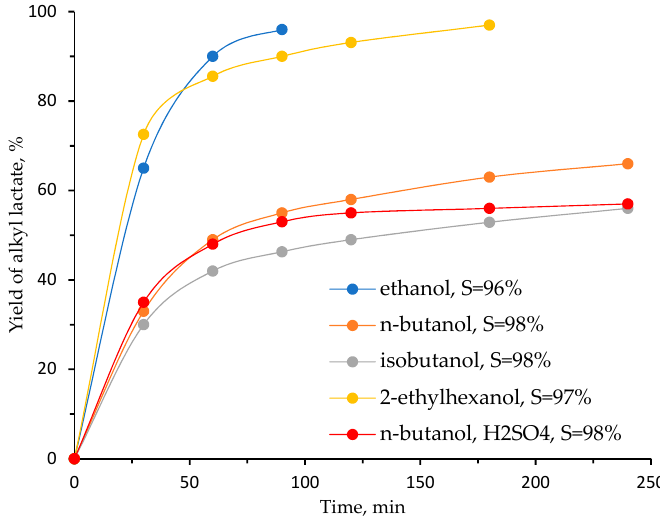
Figure 3. The influence of the alcohol structure on the yield of ester.